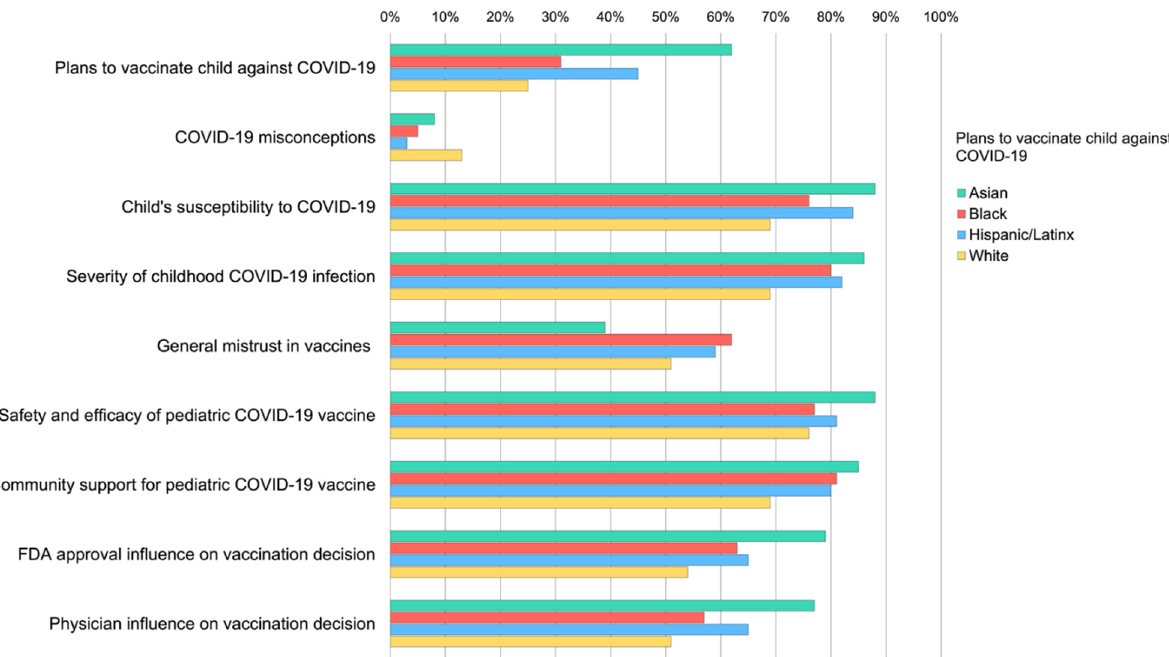
Figure 2. Endorsement of factors influencing parental pediatric COVID-19 vaccine acceptance and hesitancy by race/ethnicity . Chi-square tests of association with Bonferonni adjusted p -values indicated that race/ethnicity was significantly associated with plans to vaccinate child against COVID-19 for all variables (range = p < 0 . 05 –p < 0.001), with the exception of perceived pediatric COVID-19 vaccine safety and efficacy ( p = 0.13).